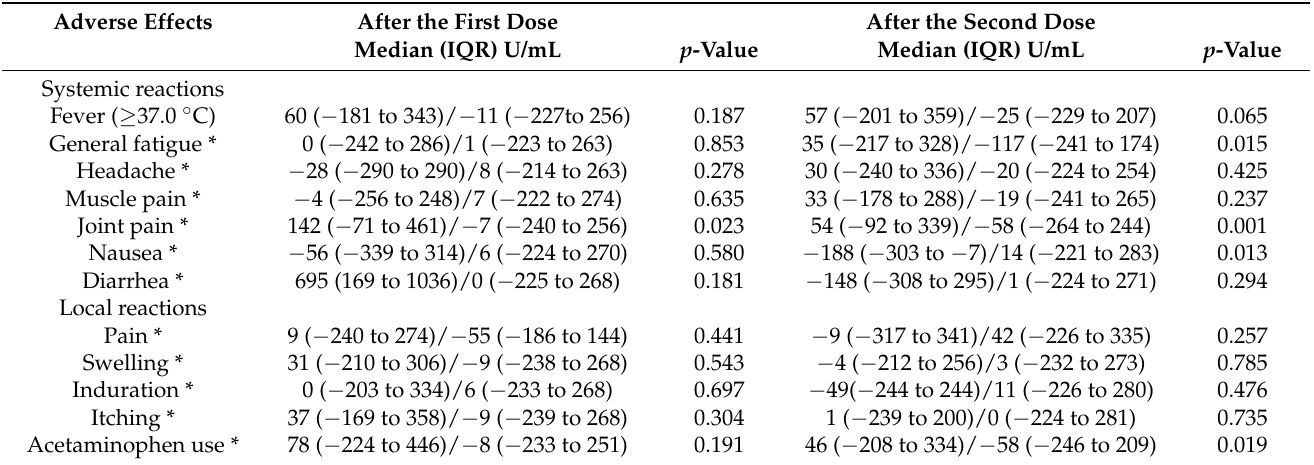
Table 4. Relationship between adverse effects and age-adjusted antibody titers at 6 months after vaccination ( n =